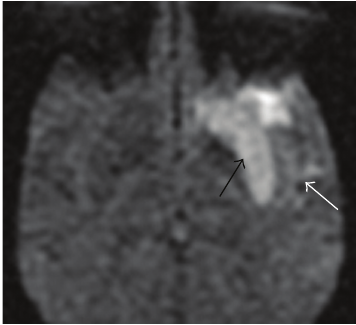
Figure 6: 1h DWI shows increased signal in basal ganglion (black arrow) but decreased signal in temporal lobe (white arrow).